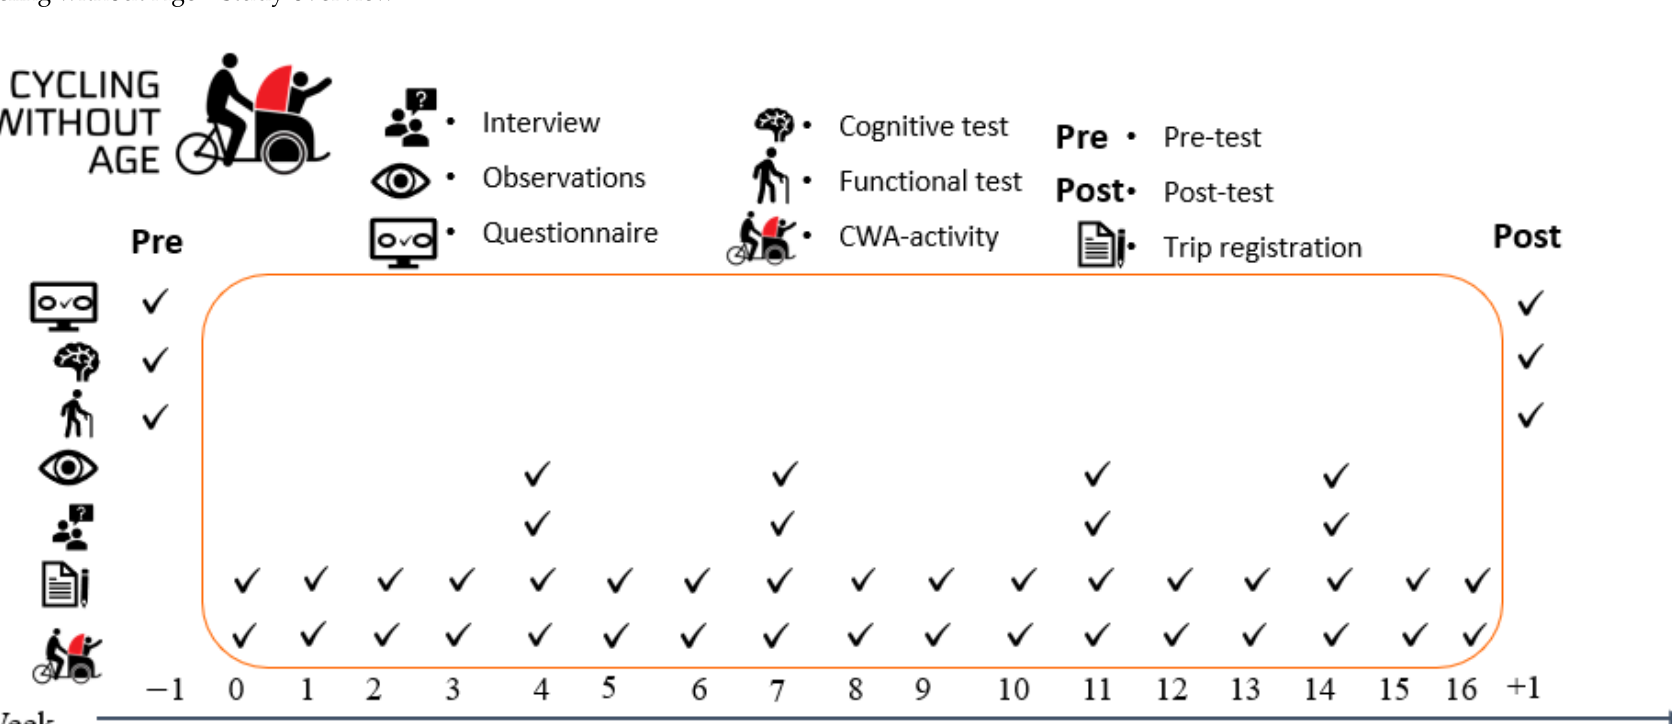
Figure 4. Overview of activities taking place during the CWA sub-project of WMM.